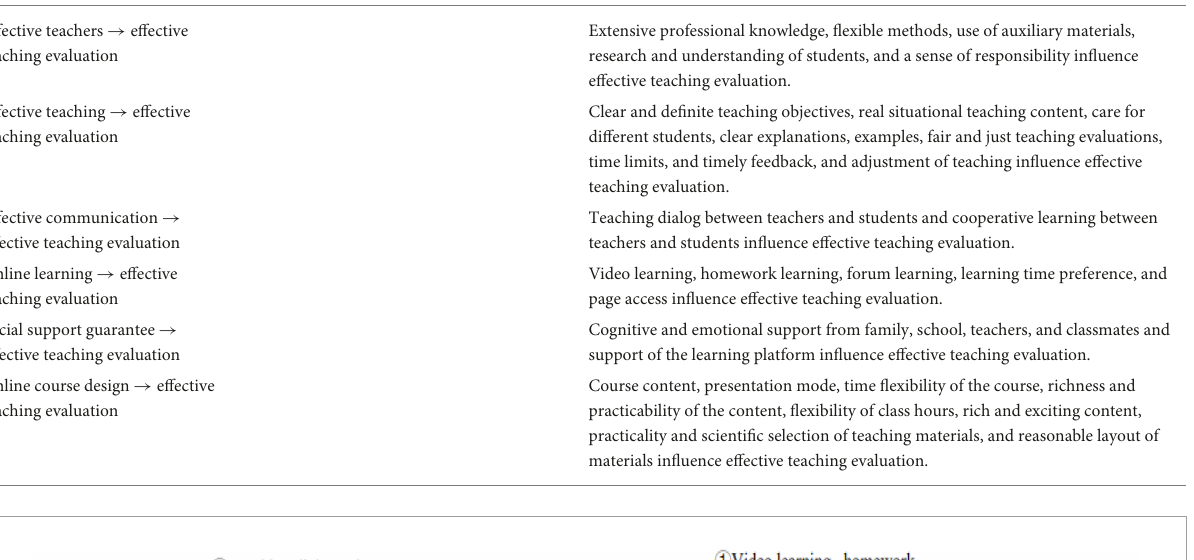
TABLE 5 Relationship structure of main categories. Relational structure Connotation of relational structure